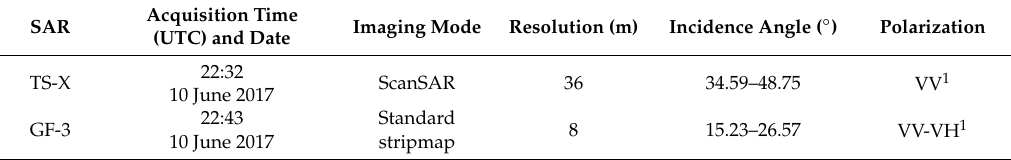
Table 1. Technical specifications of the spaceborne SAR data used in the